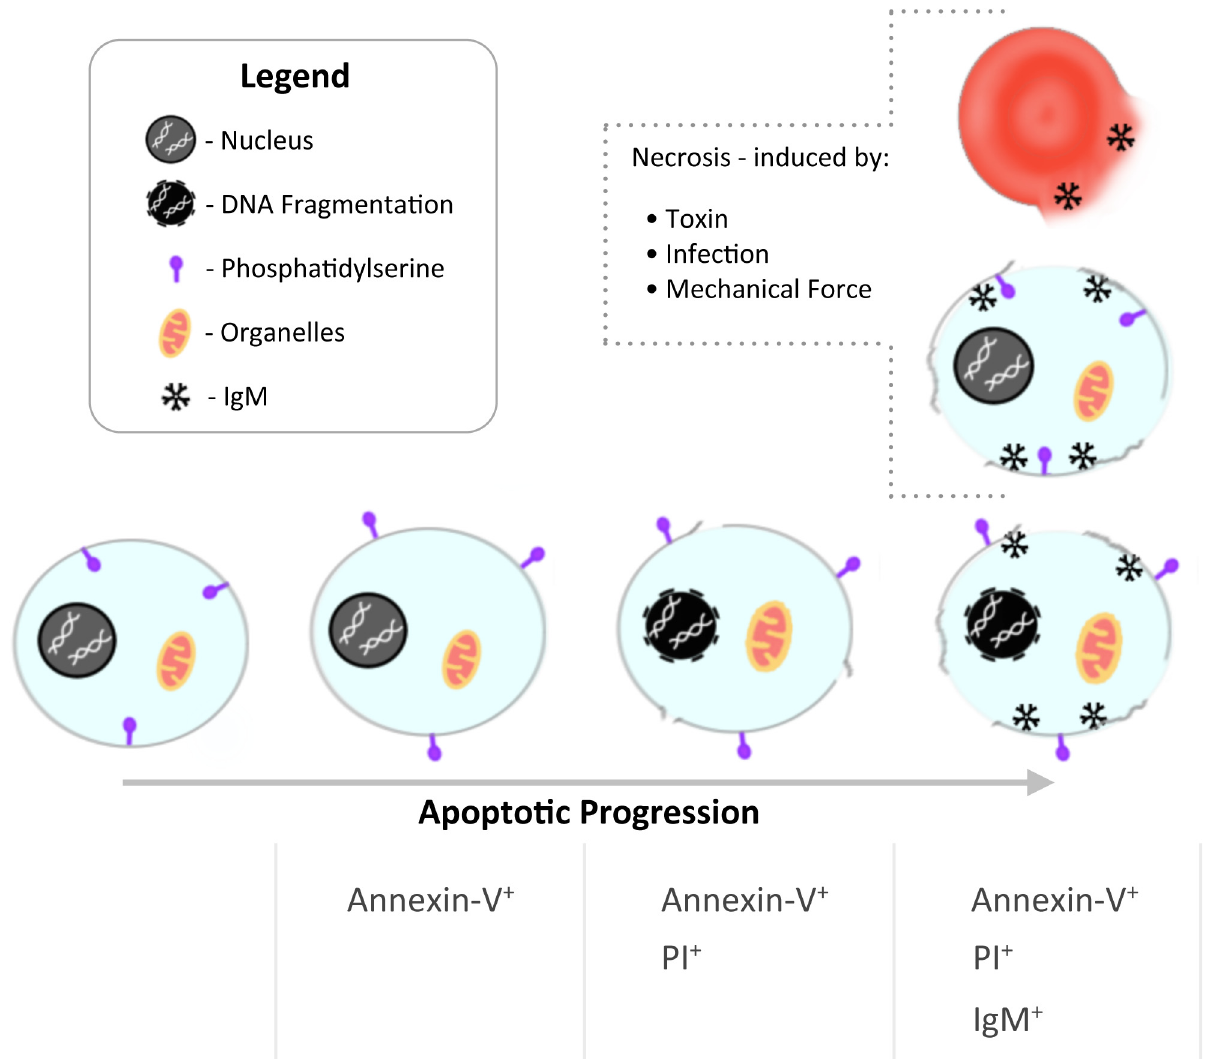
Fig 7. Schematic diagram of IgM binding to apoptotic or disrupted cells. As cells progress through apoptosis IgM binding occurs following phosphatidylserine exposure (Annexin-V binding) and loss of membrane integrity (PI binding). At this point IgM is able to bind intracellular cell membrane or cytoplasmic antigens. Similarly, IgM may bind any cells including lymphocytes or erythrocytes that have lost cellular integrity and have become permeable following cell necrosis or